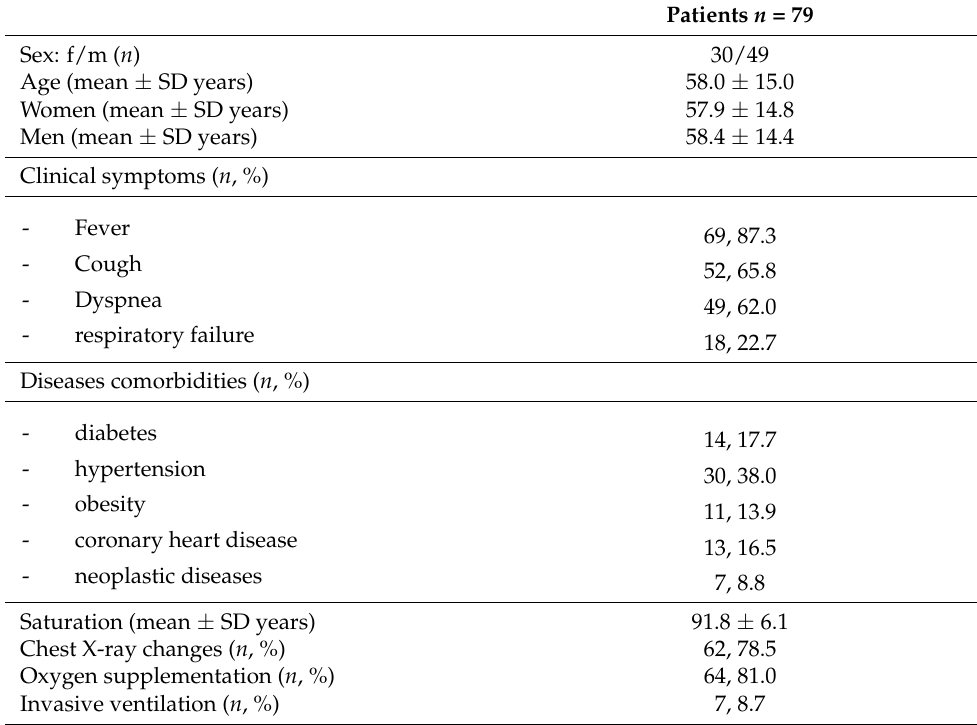
Table 2. Demographic and laboratory data of COVID-19 patients.